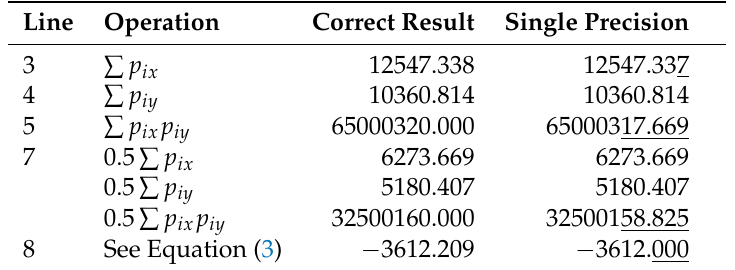
Table 1. Calculated vs. correct results of Algorithm 1 with two example